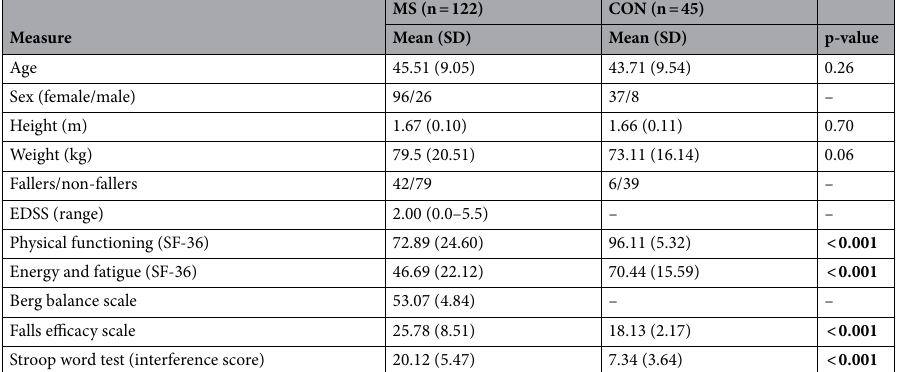
Table 3. Participant characteristics. Mean and standard deviation (SD) reported unless noted otherwise. MS multiple sclerosis, CON control, EDSS Expanded Disability Status Scale. Fall status was determined if one or more fall was reported in the previous 6 months. Berg Balance data was collected in the MS group only. Bold indicates statistical significance at the p < 0.05